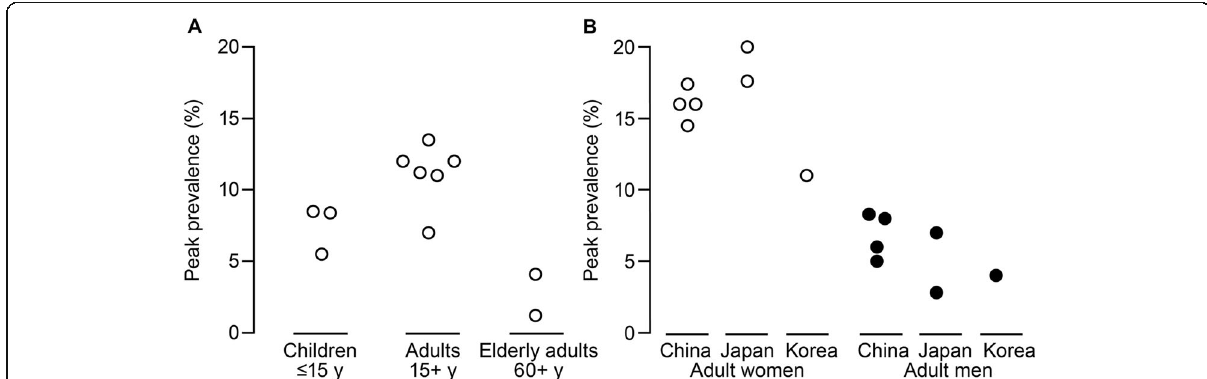
Fig. 2 Publications reporting peak prevalence (A) by age groups and (B) by country. Data in (A) were derived as follows: children [31, 36, 40], adults [20, 23, 27, 29, 43, 56], and elderly adults [30, 45]. Note, because of the age groups enrolled in each study, there was overlap in populations among the children, adult, and elderly adult categories. The prevalence of migraine in children aged 16 – 18 years from Roh et al. 2012 (14.2%) [58] is not included because of the overlap in age with adults. Data in (B) were derived as follows: China [20, 27, 29, 43], Japan [51, 53], and South Korea [56]. Roh et al. 1998 [59] used a non-standard definition of migraine for adults in South Korea and is not reported in panels A or